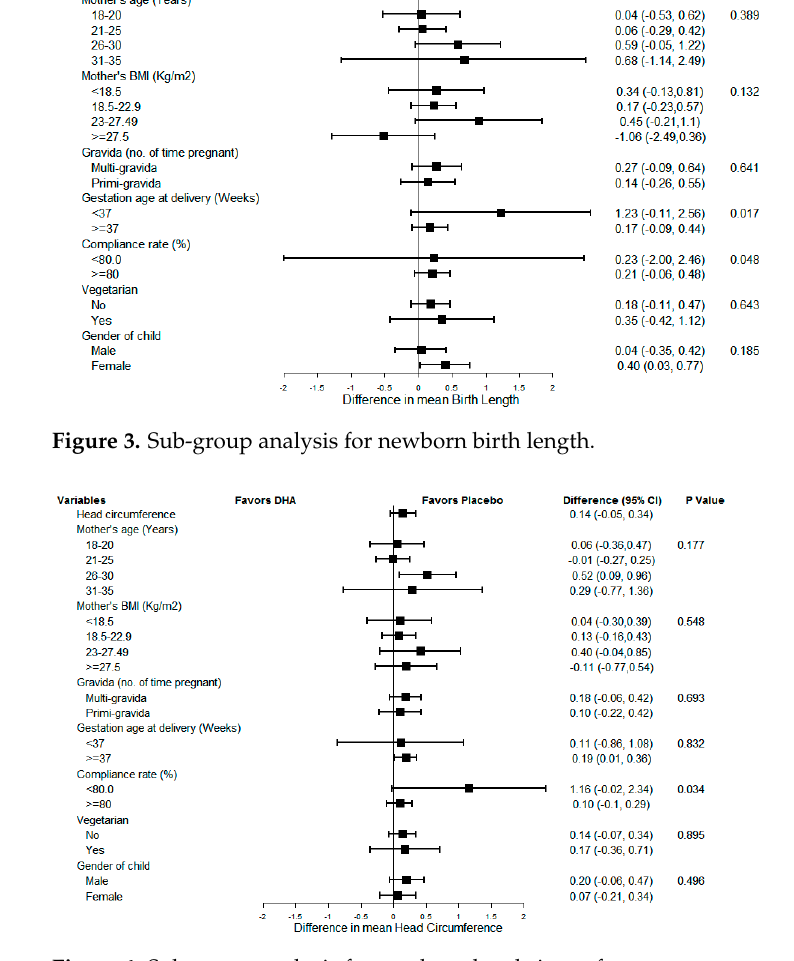
Figure 4. Sub-group analysis for newborn head circumference.